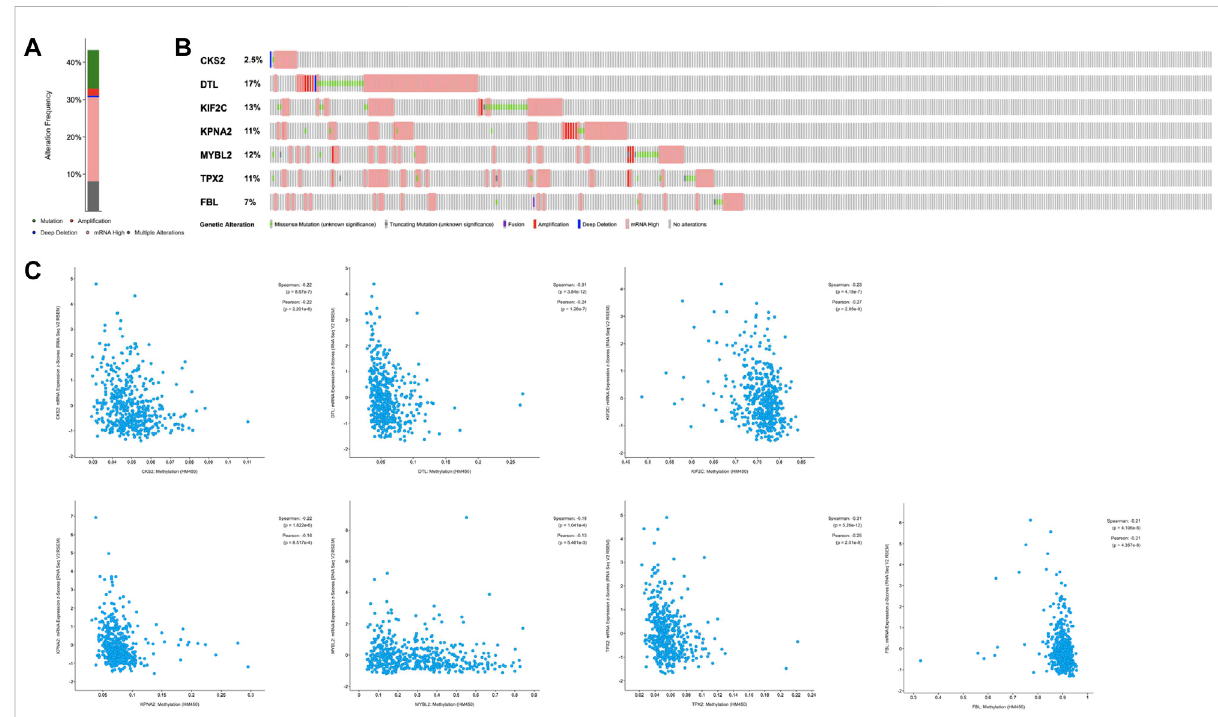
FIGURE 7 Genetic alteration of seven hub genes and the relationship betweenmRNAexpression and DNA methylation inthe TCGA SKCM study using the cBioPortaldatabase. (A) Alterationfrequencyofhubgenes. (B) Avisualsummaryofalterationbasedonaqueryofsevenhubgenes,whichwasaltered in 192 (43.24%) of 444 sequenced cases/patients. (C) The relationship between mRNA expression and DNA methylation in the seven hub